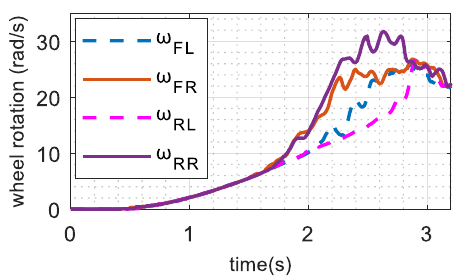
Figure 8. Wheel rotation speed controller input variables.